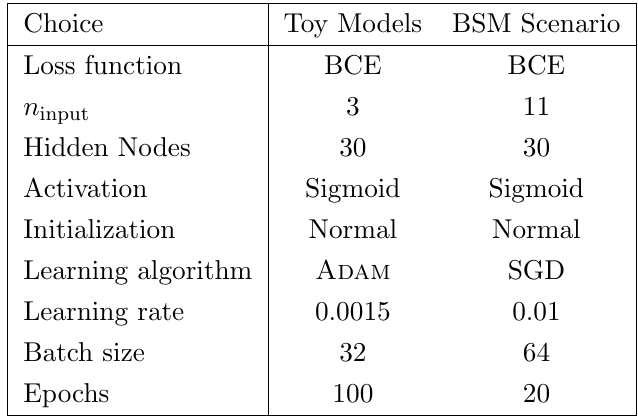
Table 1 . Values of hyper-parameters chosen for the networks used below. The learning is imple- mented using Keras [44] with the Adam optimizer [45] for the toy models and stochastic gradient descent (SGD) for the particle physics